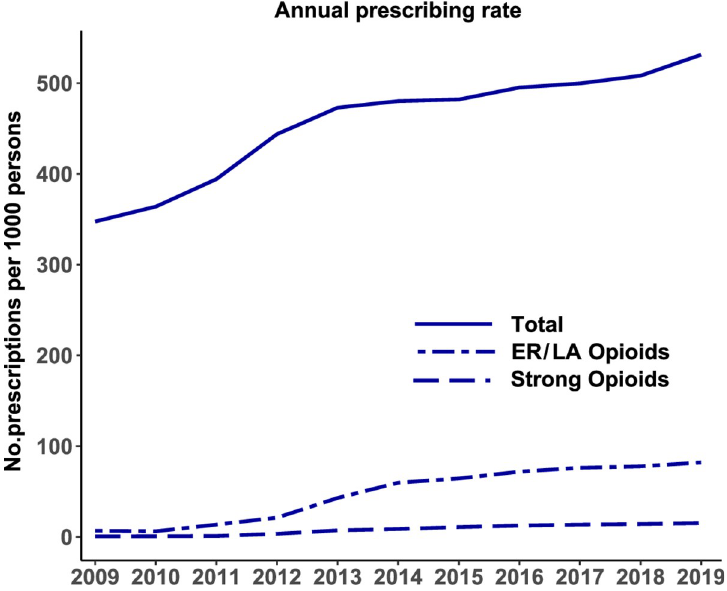
Fig 2. Annual opioid prescribing rates per 1000 persons for the three key measures (total, strong, and ER/LA opioids).